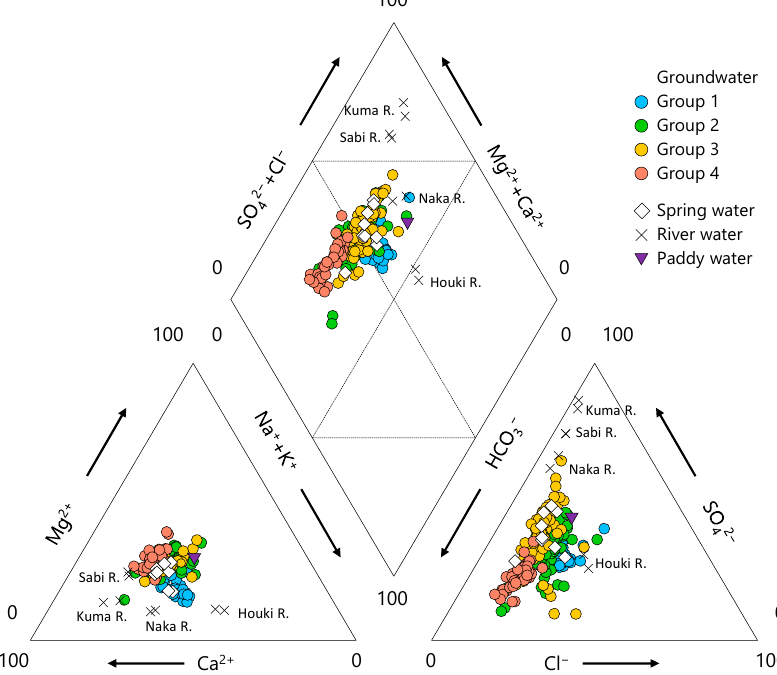
Figure 13. Trilinear diagram of the four groundwater groups.